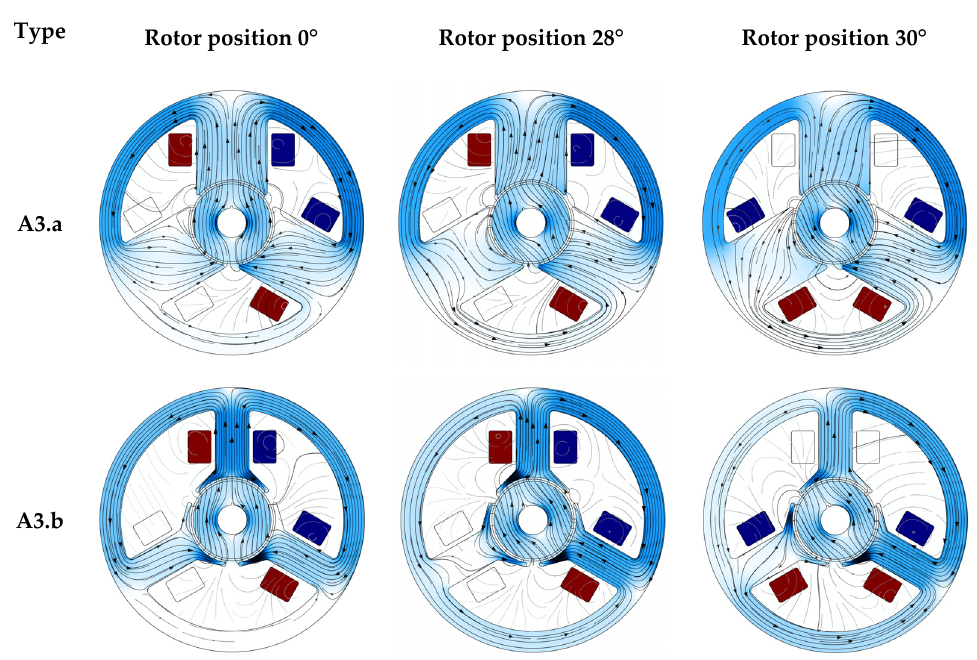
Figure 11. Examples: magnetic flux density and magnetic vector potential (lines). The position of the rotor in the subsequent drawings is 0, 28 and 30 degrees after the change of power bands, models A3.a and A3.b.